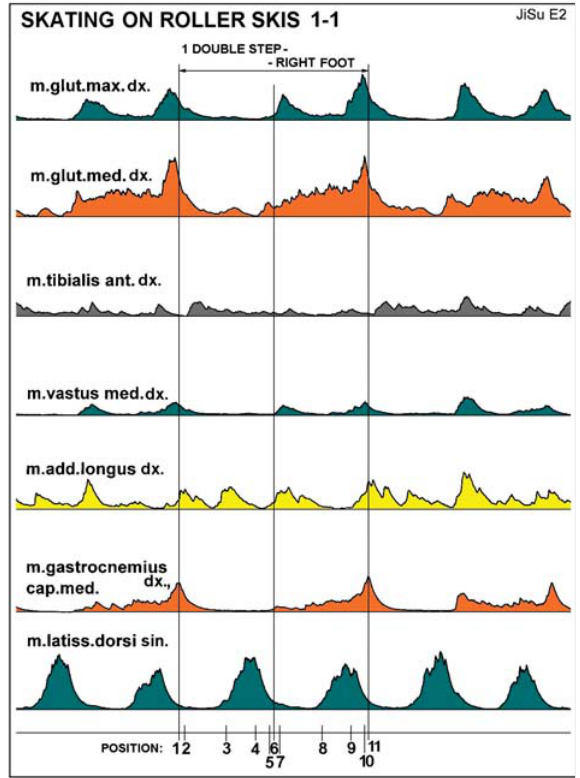
Figure 4. Process of skating on roller skis